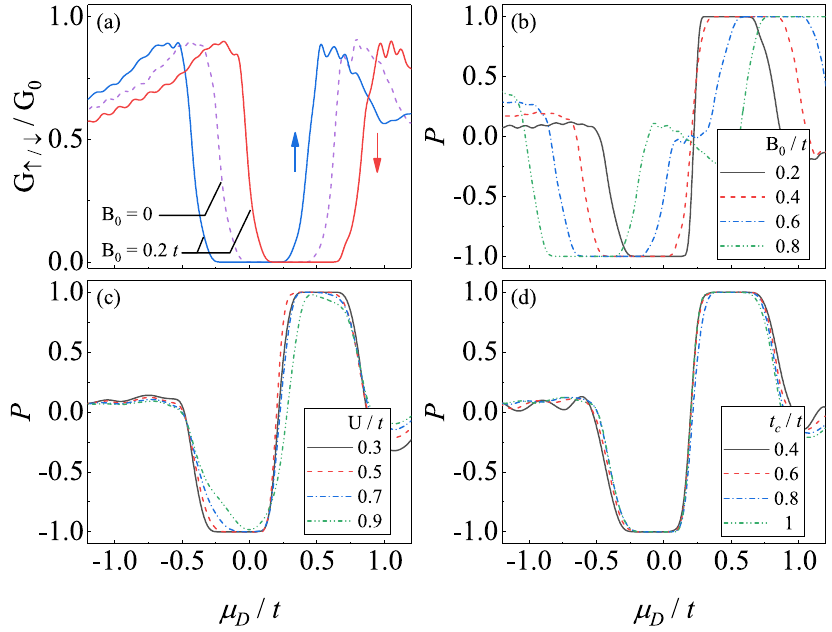
Figure 2. ( a ) The spin-dependent conductance with and without B 0 . ( b – d ) The spin polarization P via the gate voltage µ D with various ( b ) Zeeman terms B 0 , ( c ) barriers U and ( d ) coupling strength t c . The length of the junction is L x = 50 a , the barrier is U = 0.3 t , the coupling strength is t / tc = 1 and the energy of incident electron is E = 0.2 t . Other parameters are the same as those in Fig.